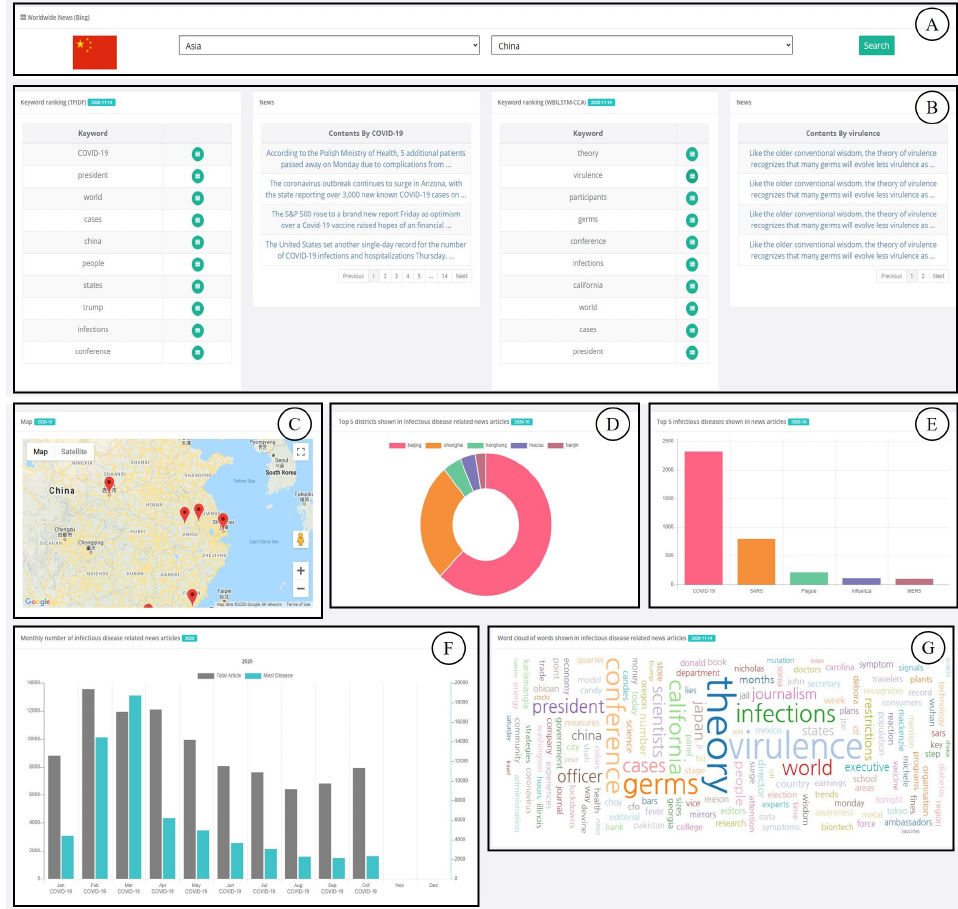
Figure 3. Web interface based on Bing News articles: ( A ): input form that allows the user to select the continent and country. ( B ) disease-related topic ranking based on the news articles collected with the disease keyword. ( C ) a map of the country ( D ) the raking of the top five districts where the largest number of disease-related news articles is reported. ( E ) the ranking of the top five diseases most frequently mentioned in disease-related news articles of the selected nation. ( F ) the trend of this year for a monthly total number of collected news articles and a monthly number of news articles of the most frequently shown disease. ( G ) disease-related word cloud based on collected disease-related news